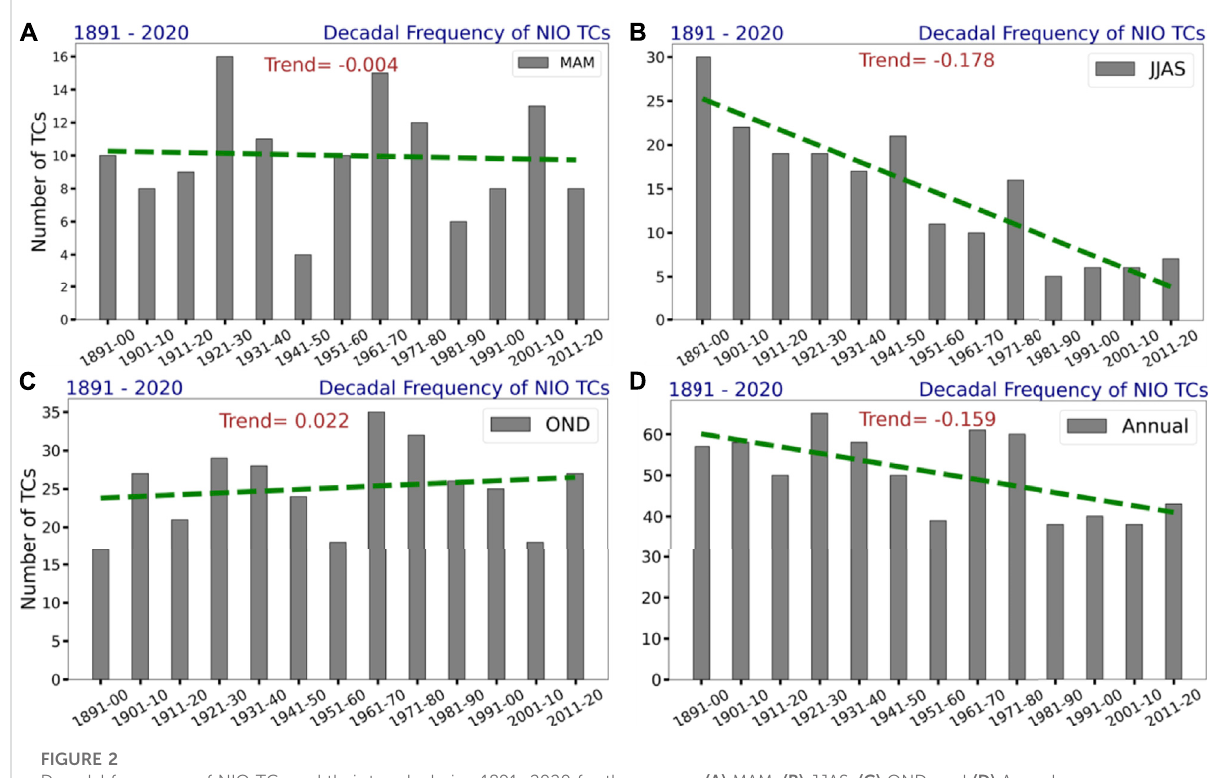
FIGURE 2 Decadal frequency of NIO TCs and their trends during 1891 – 2020 for the seasons (A) MAM, (B) JJAS, (C) OND, and (D) Annual.